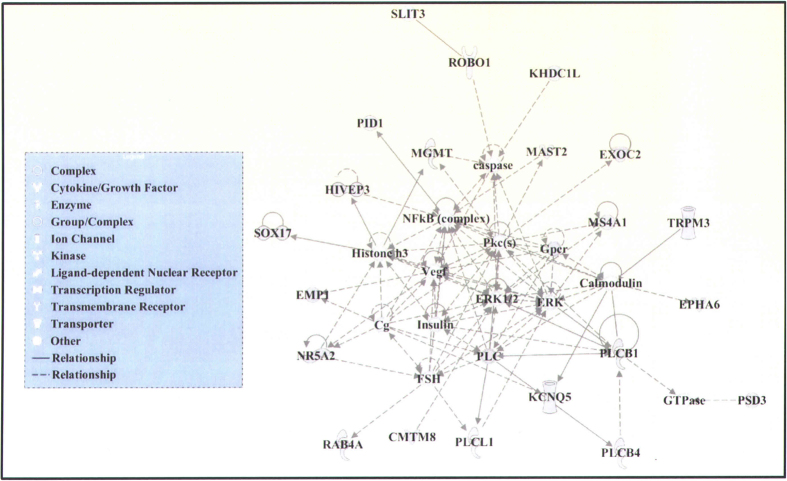
Putative gene network derived from Ingenuity Pathway Analysis (IPA) software.IPA network analysis identified a single cluster of 35 genes that includes 26 associated genes discovered in this study. The lines between genes represent known interactions (solid lines represent direct interactions; dashed lines represent indirect interactions). Each gene is displayed using various shapes that represent the functional class of the gene product, as indicated in the legend.